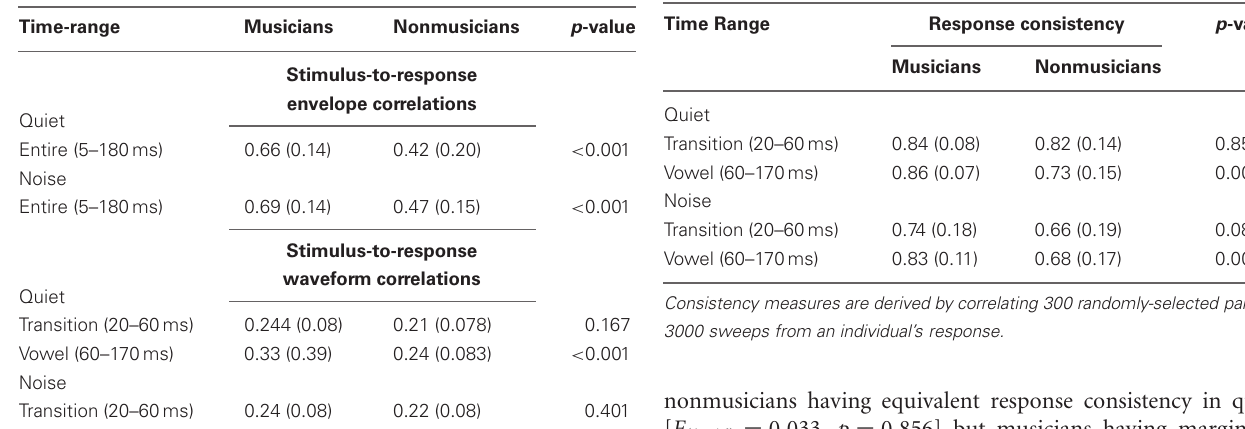
Table 4 | Stimulus-to-response (envelope and waveform) correlation values (Pearson r ): means (with SDs) for the musicians and nonmusicians across the relevant time regions.